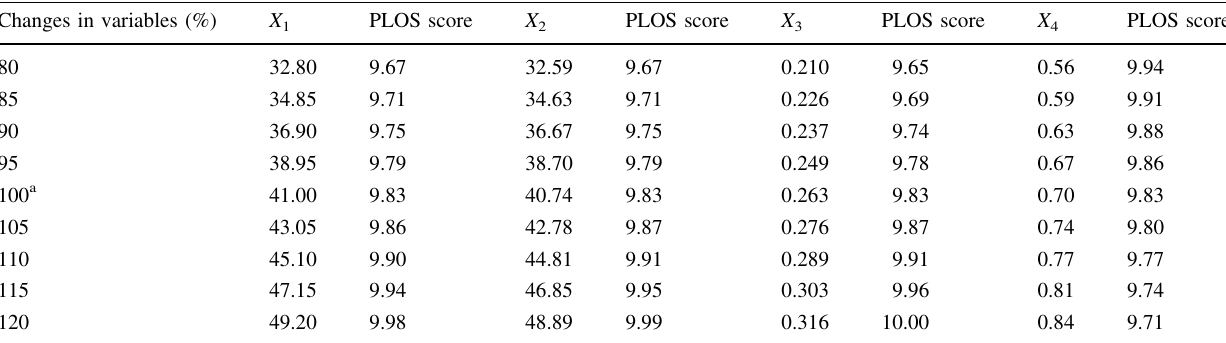
Table 9 Sensitivity analysis of PLOS variables Changes in variables